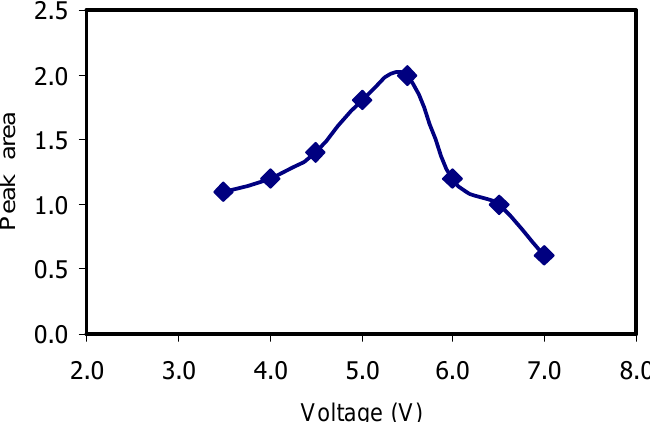
Figure 3. Relationship between peak area and voltage of the heating